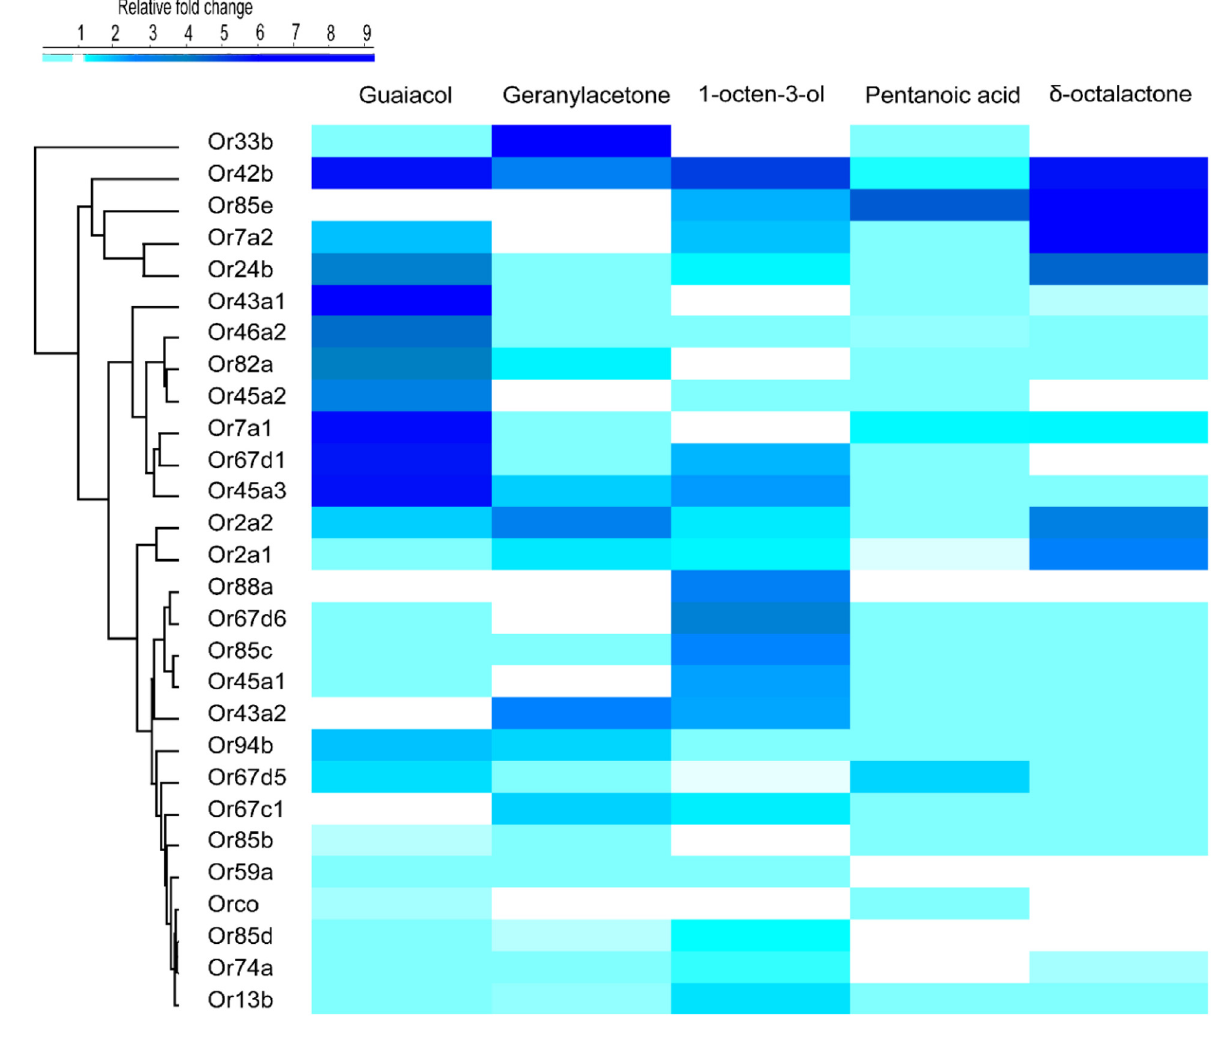
Frontiers in Cellular Neuroscience |